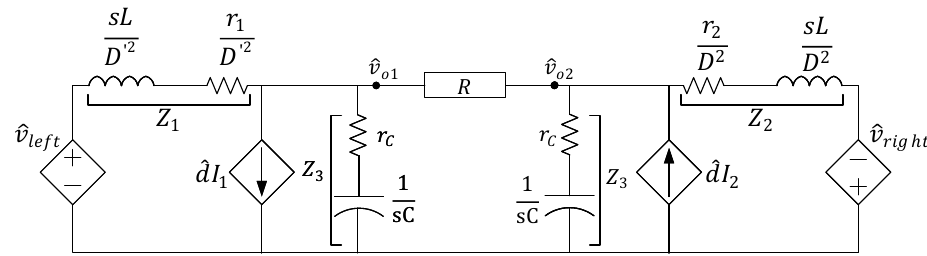
Figure 10. The ac equivalent model for obtaining the control-to-output transfer